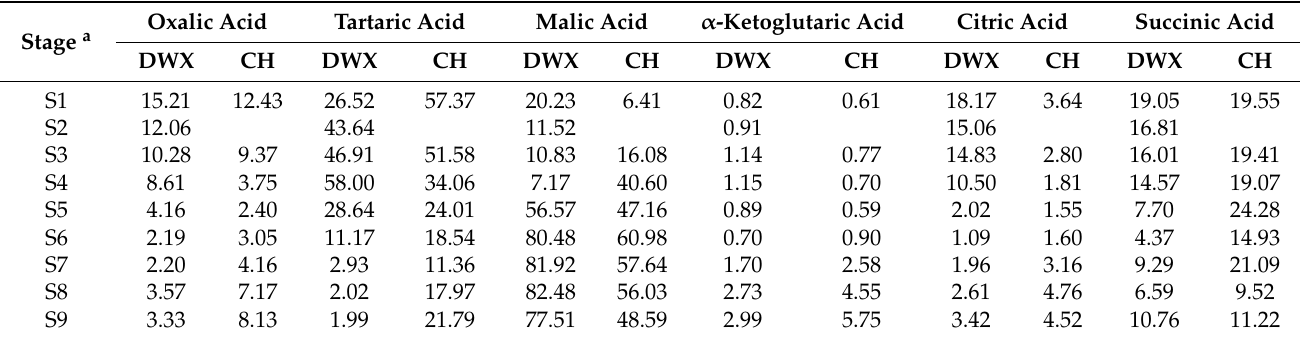
Table 1. The proportions of organic acids at different stages of fruit development and ripening of Dawuxing and Chunhua loquats.